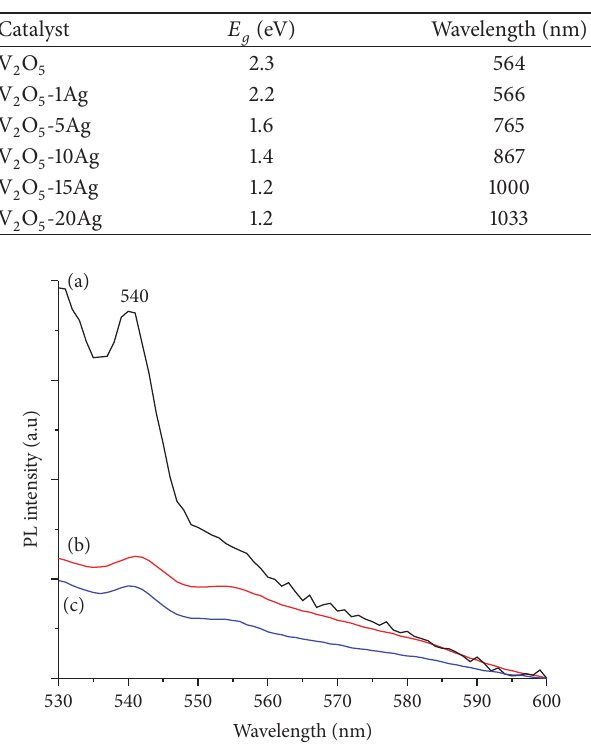
Figure 10: Photoluminescence spectra of (a) commercial V 2 O 5 , (b) synthesized V 2 O 5 , and (c) V 2 O 5 -20Ag.